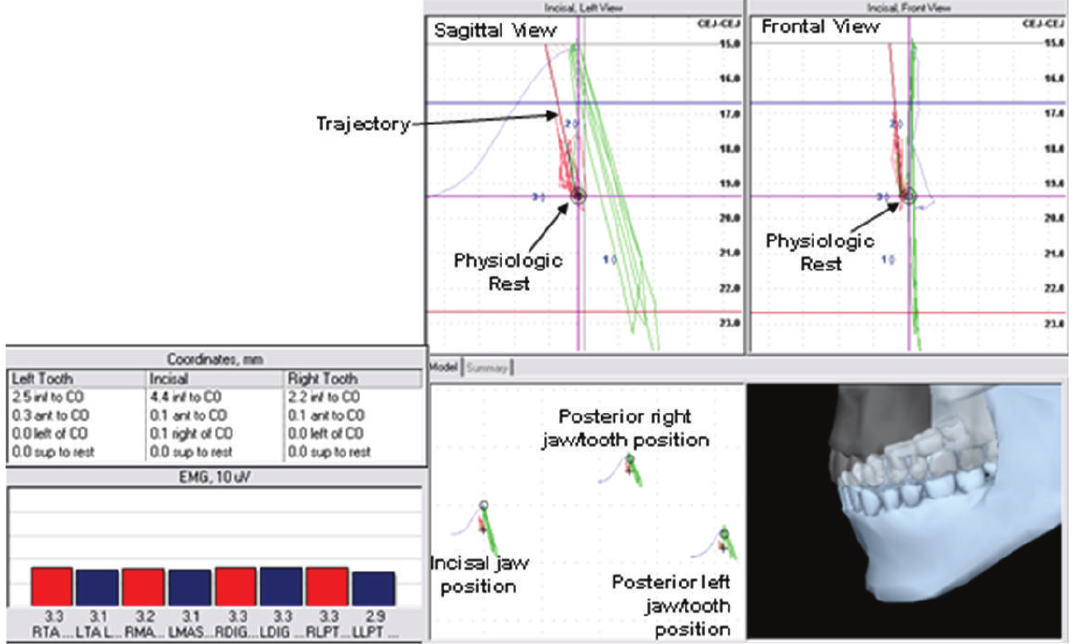
Figure6:SpatialpositionofthelowerjawcombinedwithbilateralSEMGactivityofthetemporalisanterior(TA),masseter(MAS),suprahyoid (DIG), and lateral pterygoid (LPT) sites. Coordinates listed are representative of mandibular position relative to centric occlusion and physiologic